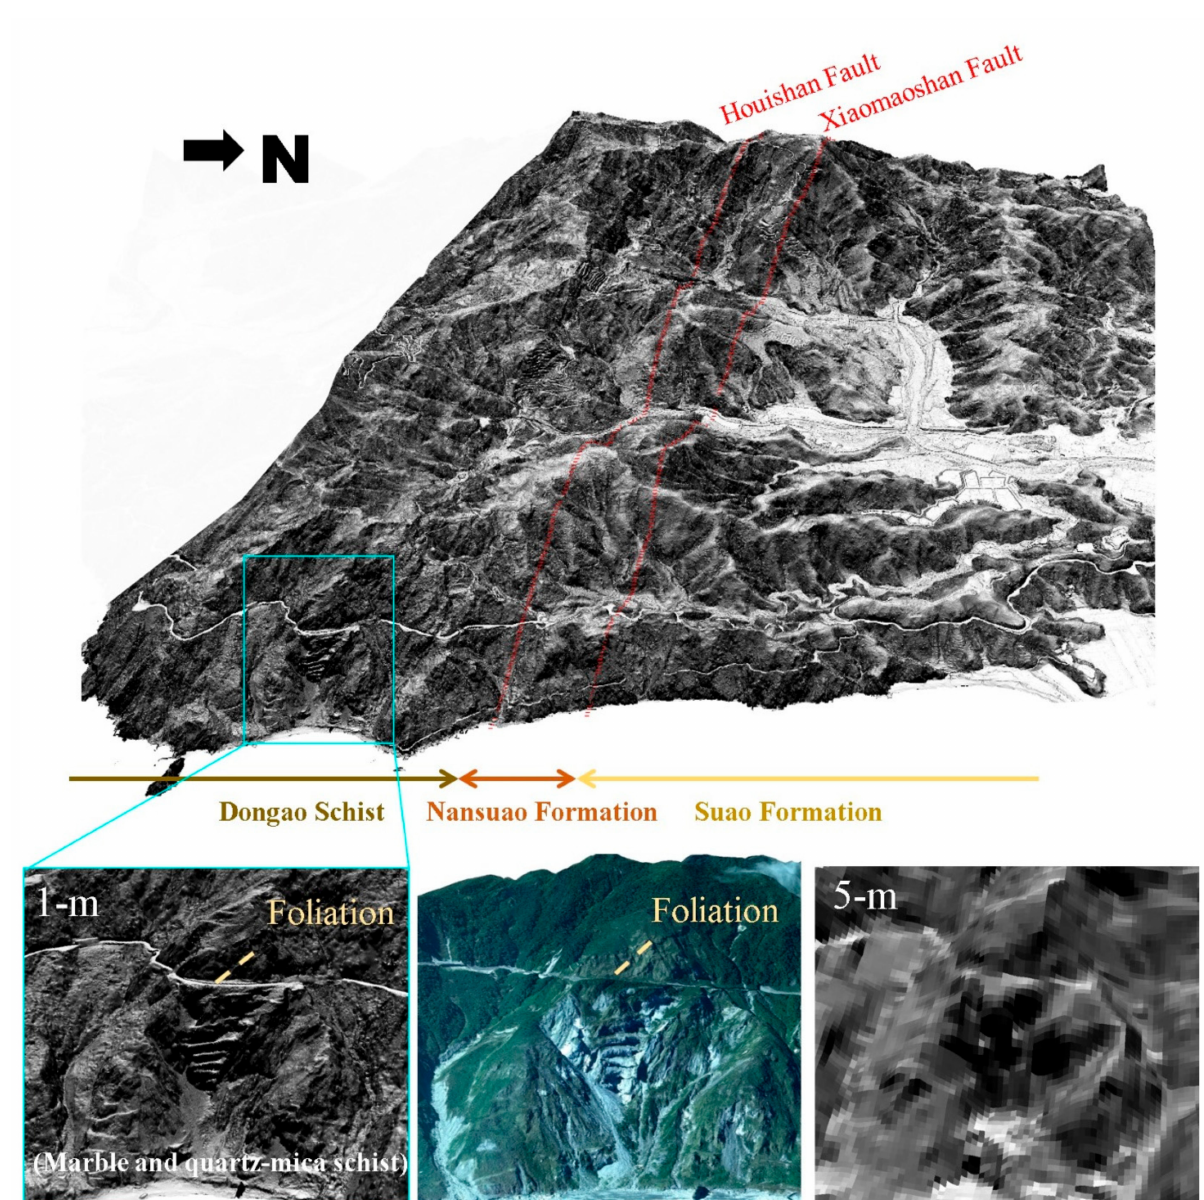
Figure 5. 3D clinometric map of the study area. Red lines denote the fault determined by conventional geological surveying and mapping, as presented in Figure